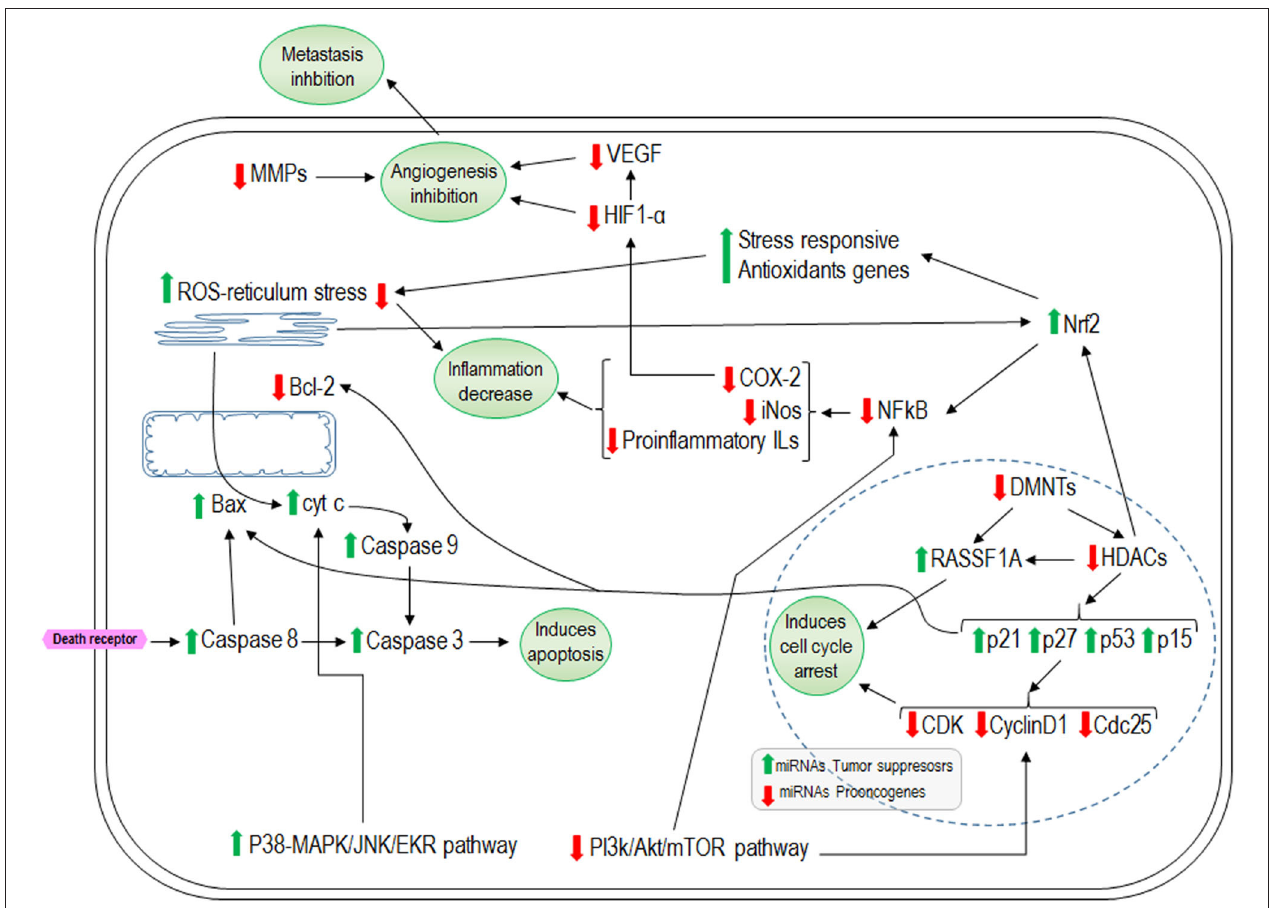
FIGURE 4 | Representative effects of isothiocyanates on cellular cycle arrest, apoptosis, inflammation, and angiogenesis. Green arrows indicate the pathways that isothiocyanates increase and the red arrows the inhibited ones. HDACs, histone deacetylases; DNMTs, methyltranspherases MMPs; RASSF1A, Ras-association domain family 1 isoform A; ROS, reactive oxygen species; COX-2, ciclooxigenasa 2; HIF-1 α , hypoxia inducible factor-1 α ; VEGF, Vascular Endothelial Growth